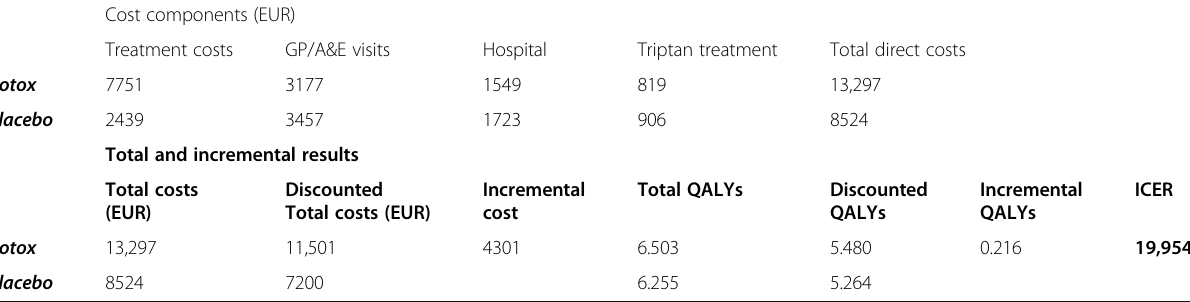
Table 7 Base case results, Norway Cost components